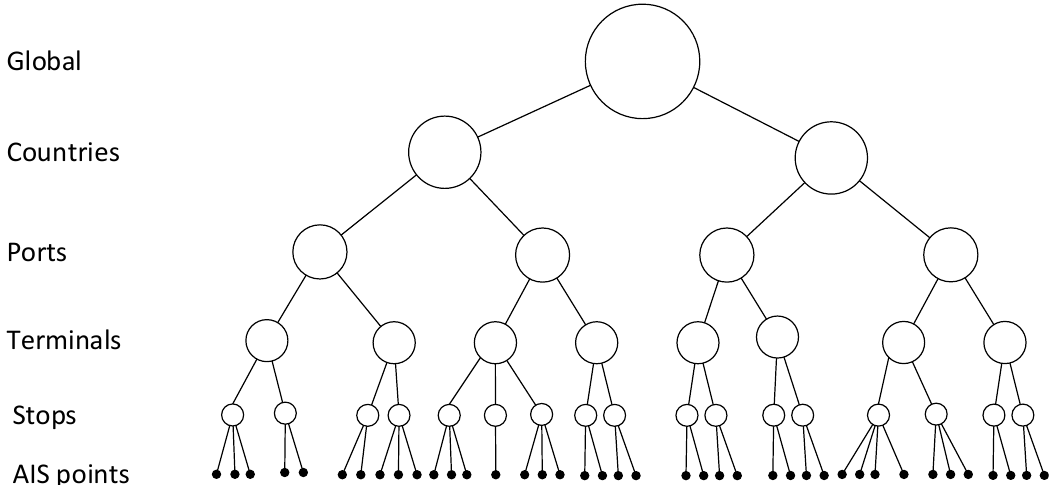
Figure 3. A bottom-up tree-based hierarchical structure of global ship stay locations with incoming AIS data at the bottom level. Global is at the top level, while the stops, terminals, ports, and countries are modelled at the middle